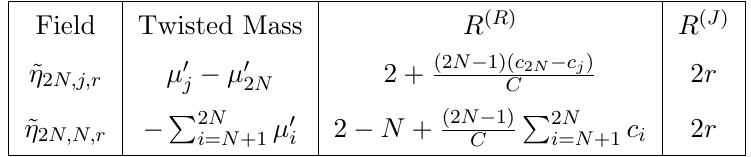
Table 3 . The decoupled (cid:12)elds that come from ~ q size mode in the (cid:12)rst case of